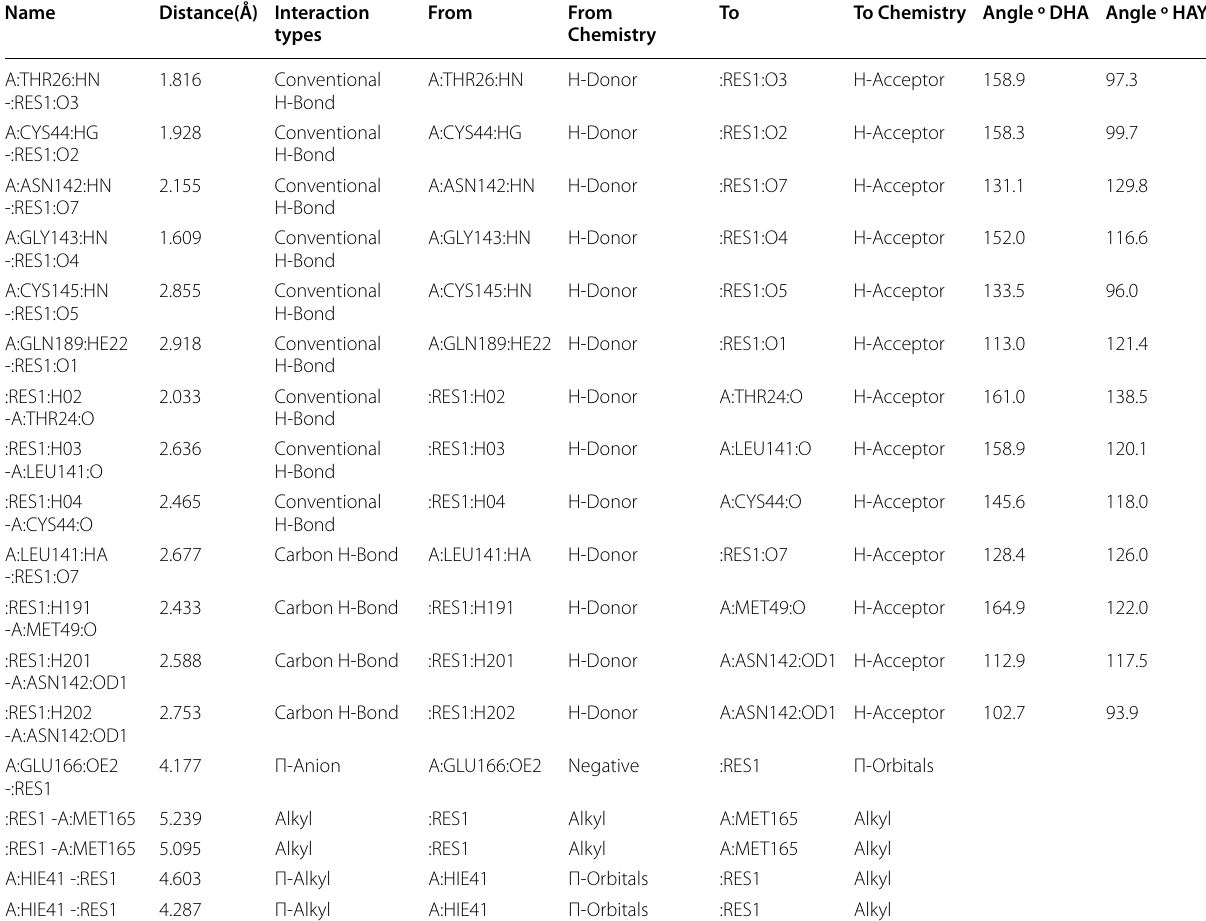
Table 9 Interaction types of surrounding amino acids of SARS CoV 2 Main Protease (PDB ID: 6XBH) with inhibitor with Index number 46d Name Distance(Å) Interaction From From types